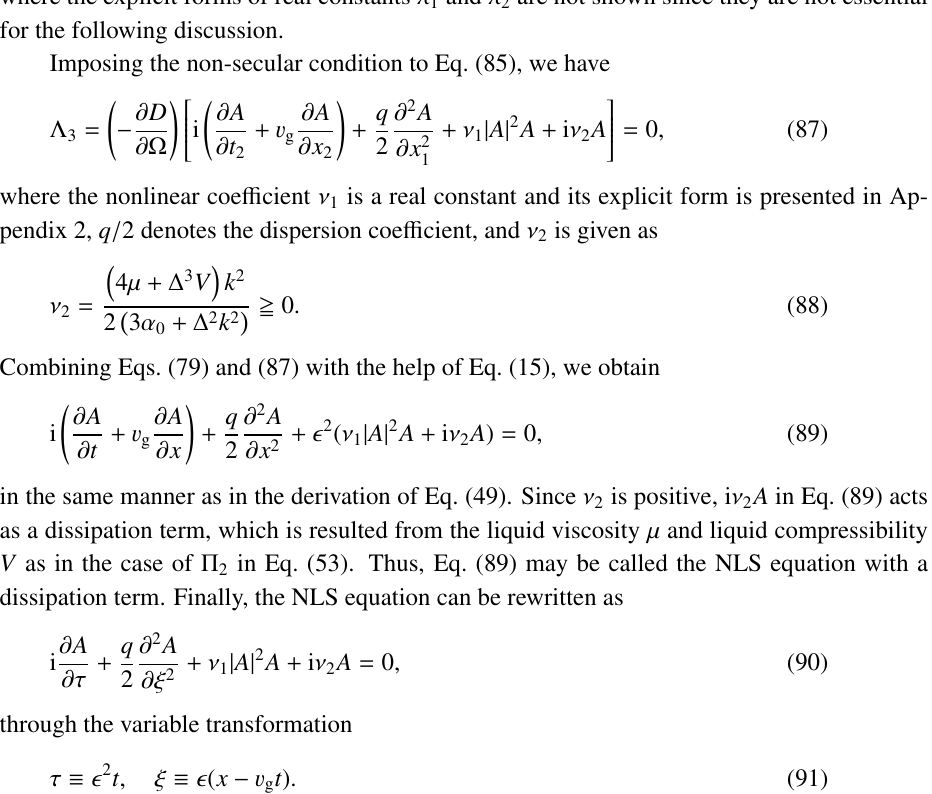
Fig. 4 The nonlinear coe ffi cient ν 1 , dissipation coe ffi cient ν 2 , and dispersion coe ffi cient q / 2 versus the wavenumber k in the case that the physical quantities except (cid:3) and Ω are the same as those used in Fig. 2, where (cid:3) = 0 . 07 and Ω varies with the variation of k as shown in Eq. (71). Long waves around k = 0 are outside the applicability of the present analysis based on parameter scaling